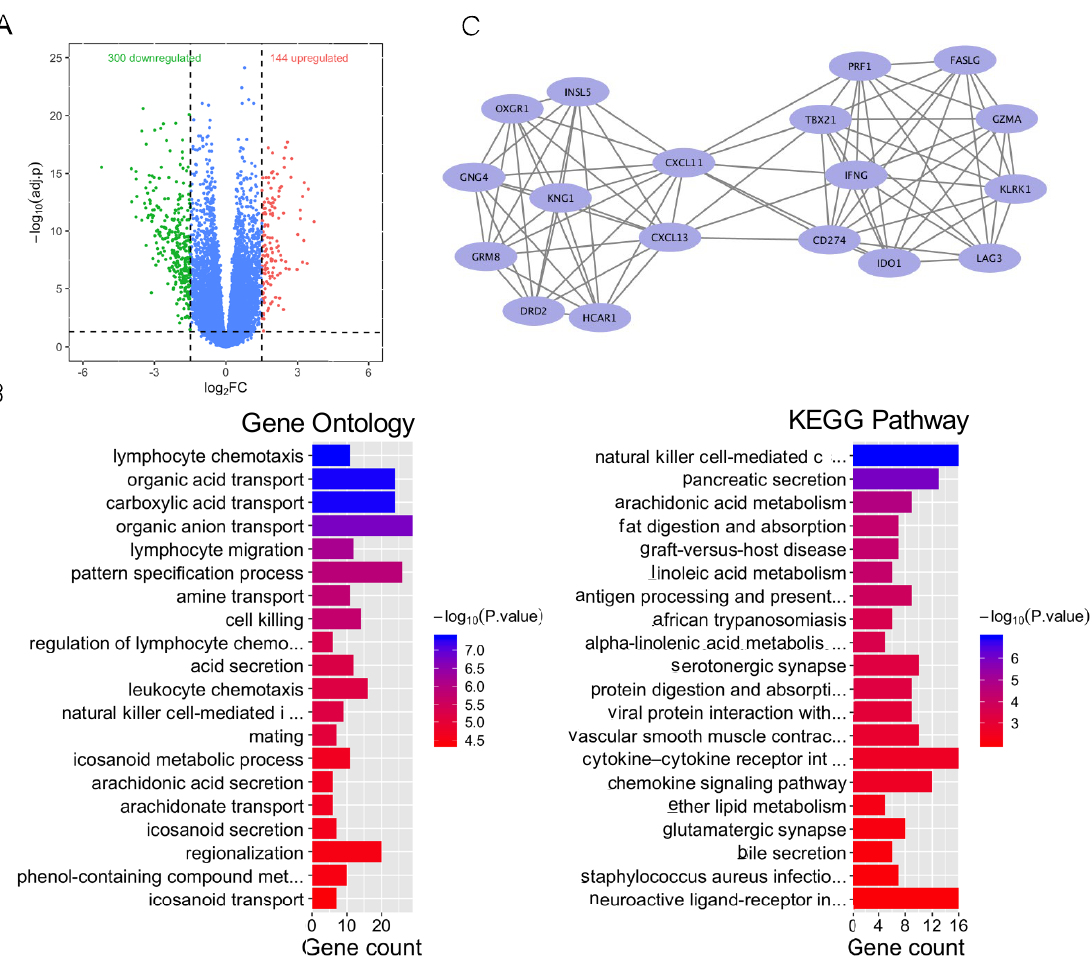
Figure 3. Bioinformatics analysis of differentially expressed genes of the high- and low-TMB group. ( A ) Volcano plot of differentially expressed genes among the high- and low-TMB group. ( B ) GO and KEGG enrichment of differentially expressed genes in the high- and low-TMB group. Blue color indicates lower p value. Red color indicates higher p value. ( C ) Main gene clusters.